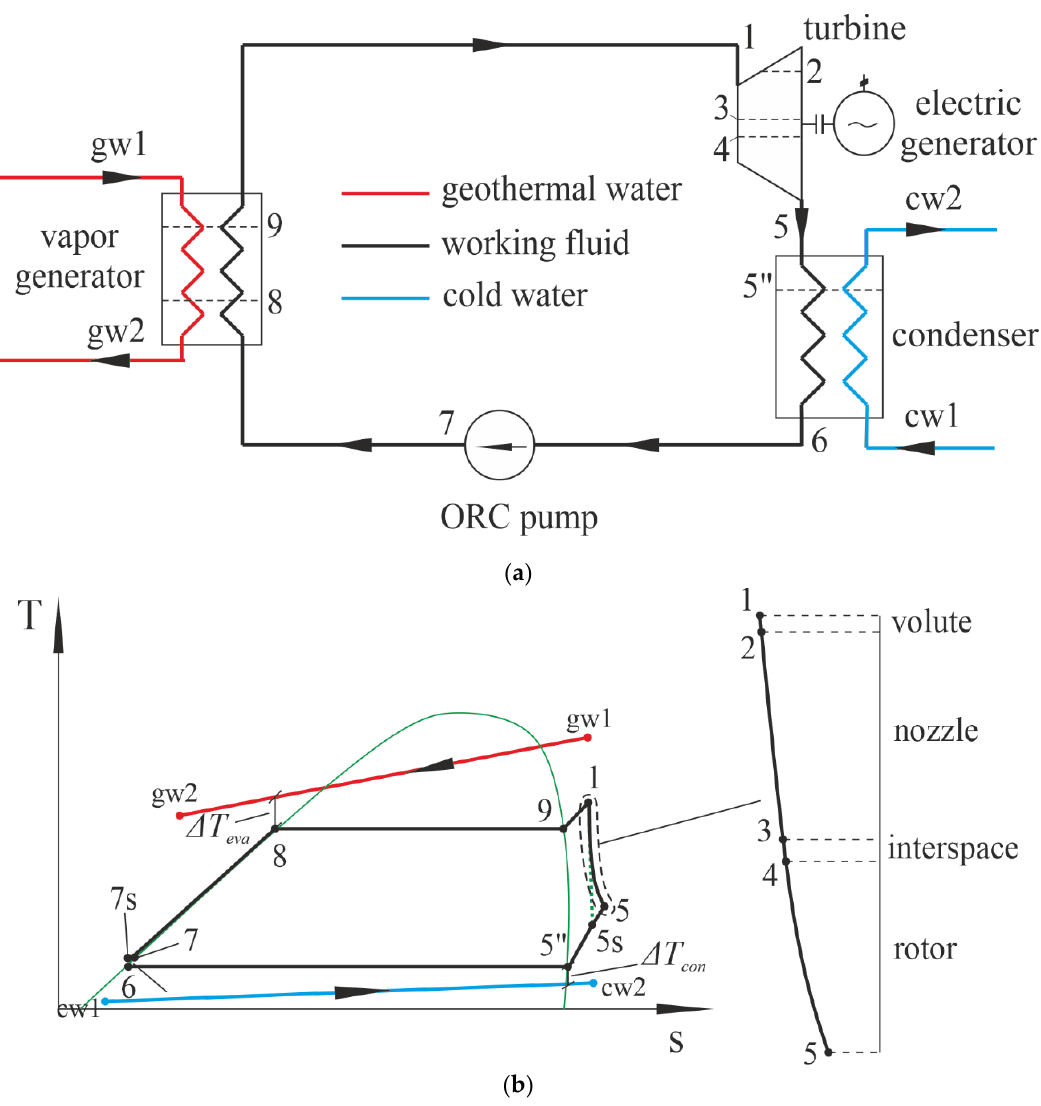
Figure 1. ( a )—organic Rankine cycle (ORC) system architecture ( b )—T-s diagram with ORC and simplified temperature distributions of geothermal and cold water [26].